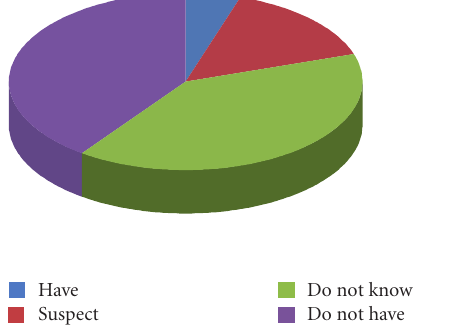
Figure 7: Chart of the participant’s knowledge of their own